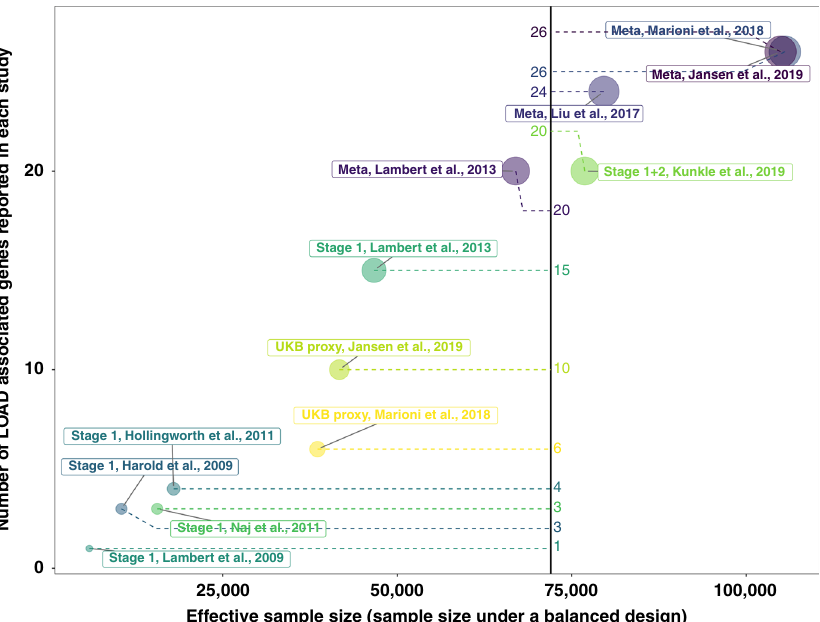
Fig. 1 The relationship between sample size and number of identi fi ed genes. Sample size is calculated as the total number of cases and controls under a balanced design (50% cases and 50% controls). Genes associated with LOAD were collected from different studies. They are the closest genes to SNPs (minor allele frequency >0.01) genome-wide signi fi cantly ( P < 5 × 10 − 8 ) associated with LOAD. “ Stage 1 ” means summary statistics based on the samples from stage 1 in that study and “ Meta ” means summary statistics from the meta-analysis from that